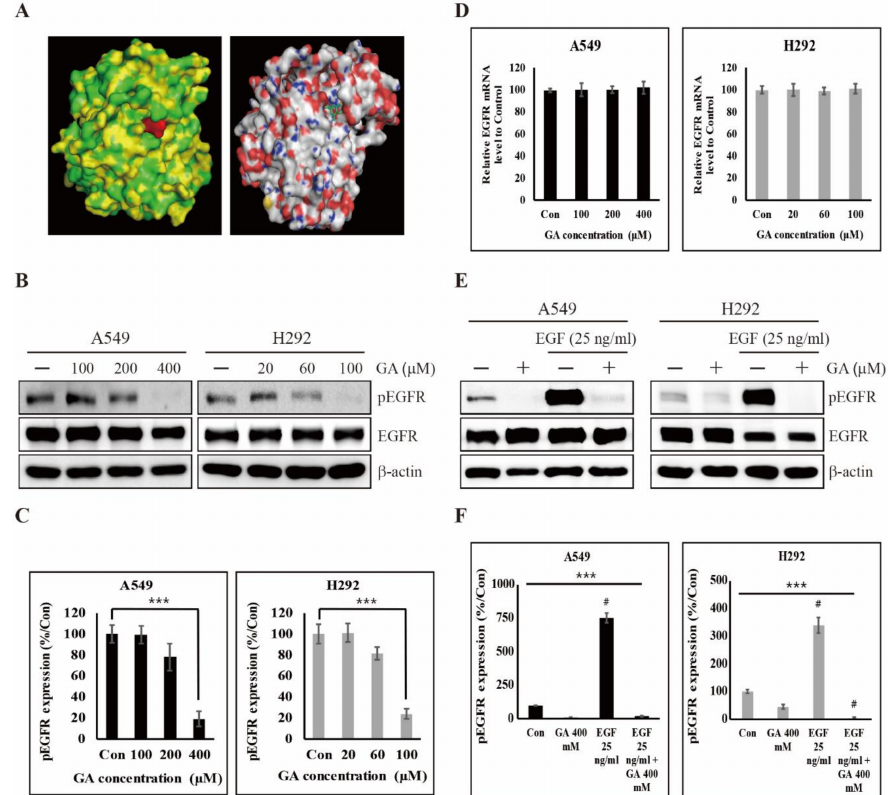
Figure 2. GA binding to epidermal growth factor receptor (EGFR) inhibits the phosphorylation of EGFR. ( A ) Binding of GA (PubChem CID: 370) to the ATP-binding domain of EGFR (Protein Data Bank ID: 4LQM) as determined by molecular docking using AutoDock Vina. ( B ) The expression levels of total EGFR and phosphorylated EGFR (pEGFR) protein in A549 and H292 cells were detected after GA treatment in concentrations indicated for 48 hours. ( C ) The relative levels of pEGFR protein were determined by densitometry and normalized to β -actin. Data are representative of three independent experiments. *** p < 0.001 ( t- test). ( D ) The expression levels of EGFR mRNA in A549 and H292 cells were detected by real time PCR after GA treatment in concentrations indicated for 48 hours. The relative levels of EGFR mRNA were determined and normalized to GAPDH mRNA. Data are representative of three independent experiments. ( E ) A549 and H292 cells for detecting the expression levels of total EGFR and pEGFR protein were treated with or without 25 ng / mL EGF for 15 minutes and then further treated with GA (A549: 400 µ M; H292: 100 µ M) for 48 hours. ( F ) The relative levels of pEGFR protein were determined by densitometry and normalized to β -actin. Data are representative of three independent experiments. *** p < 0.001 ( t- test). # p < 0.001 vs.